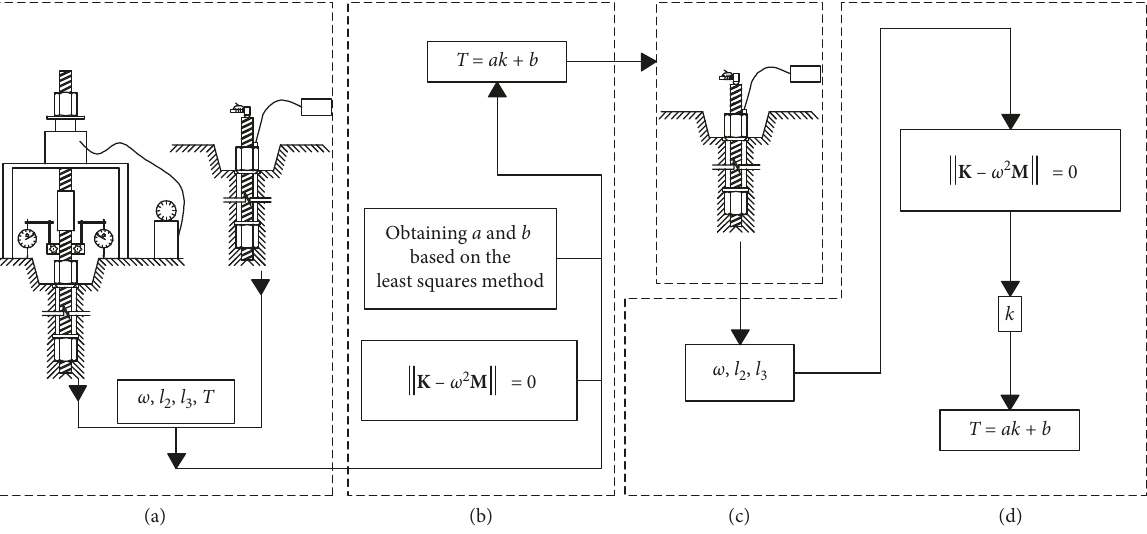
Figure 16: Diagram describing the test principle.